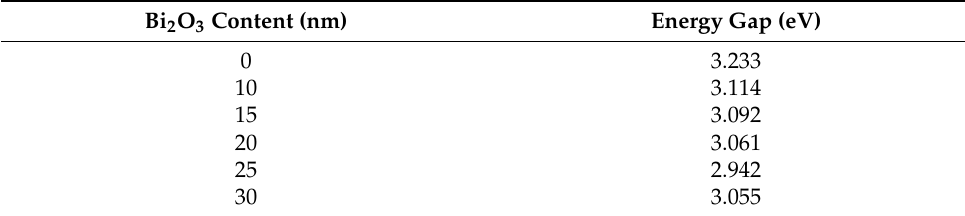
Table 1. Energy gap widths of each experimental